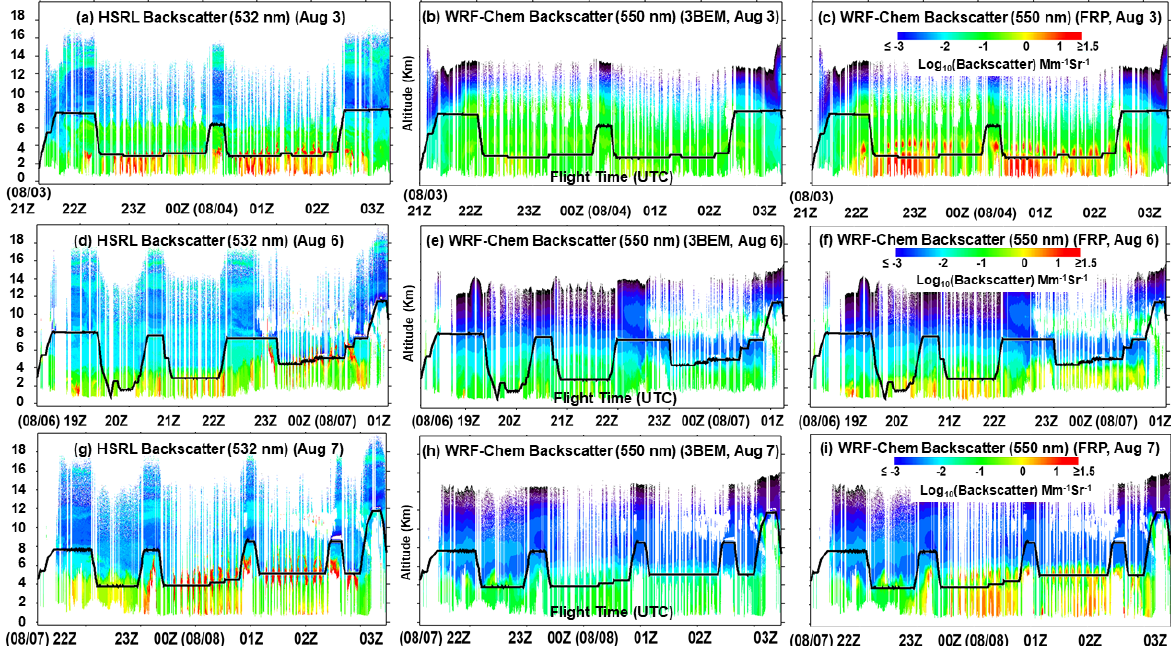
Figure 9. Flight curtains for the HSRL backscatter along with the WRF-Chem (3BEM and FRP versions) simulated backscatter (DC-8 science flights for 3 August a–c , 6 August d–f , and 7 August g–i